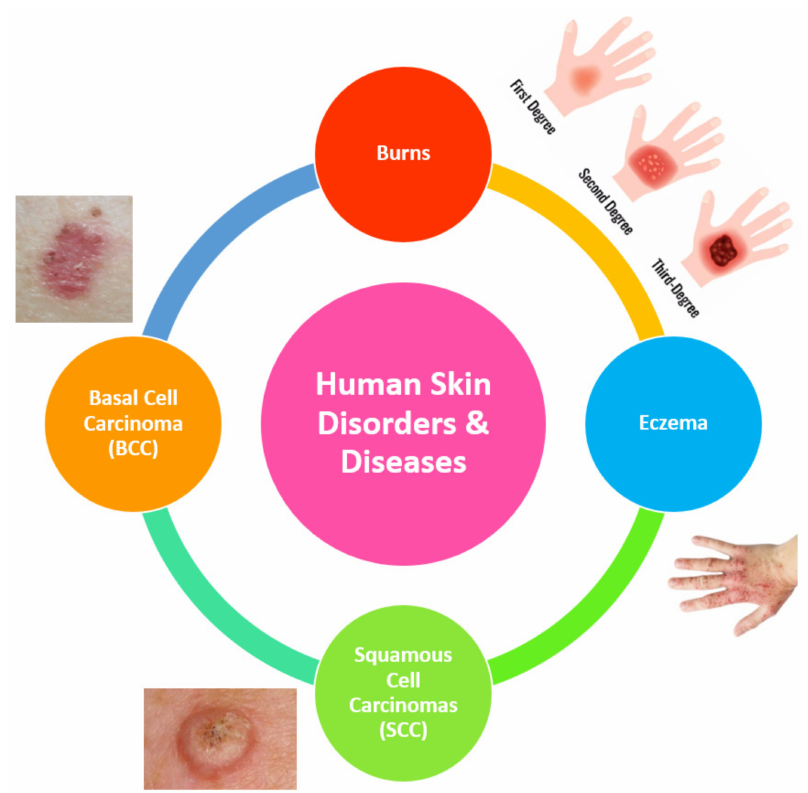
Figure 1. Skin conditions and diseases that might appear during the life cycle of a human. The images of the skin were obtained from open-access sources